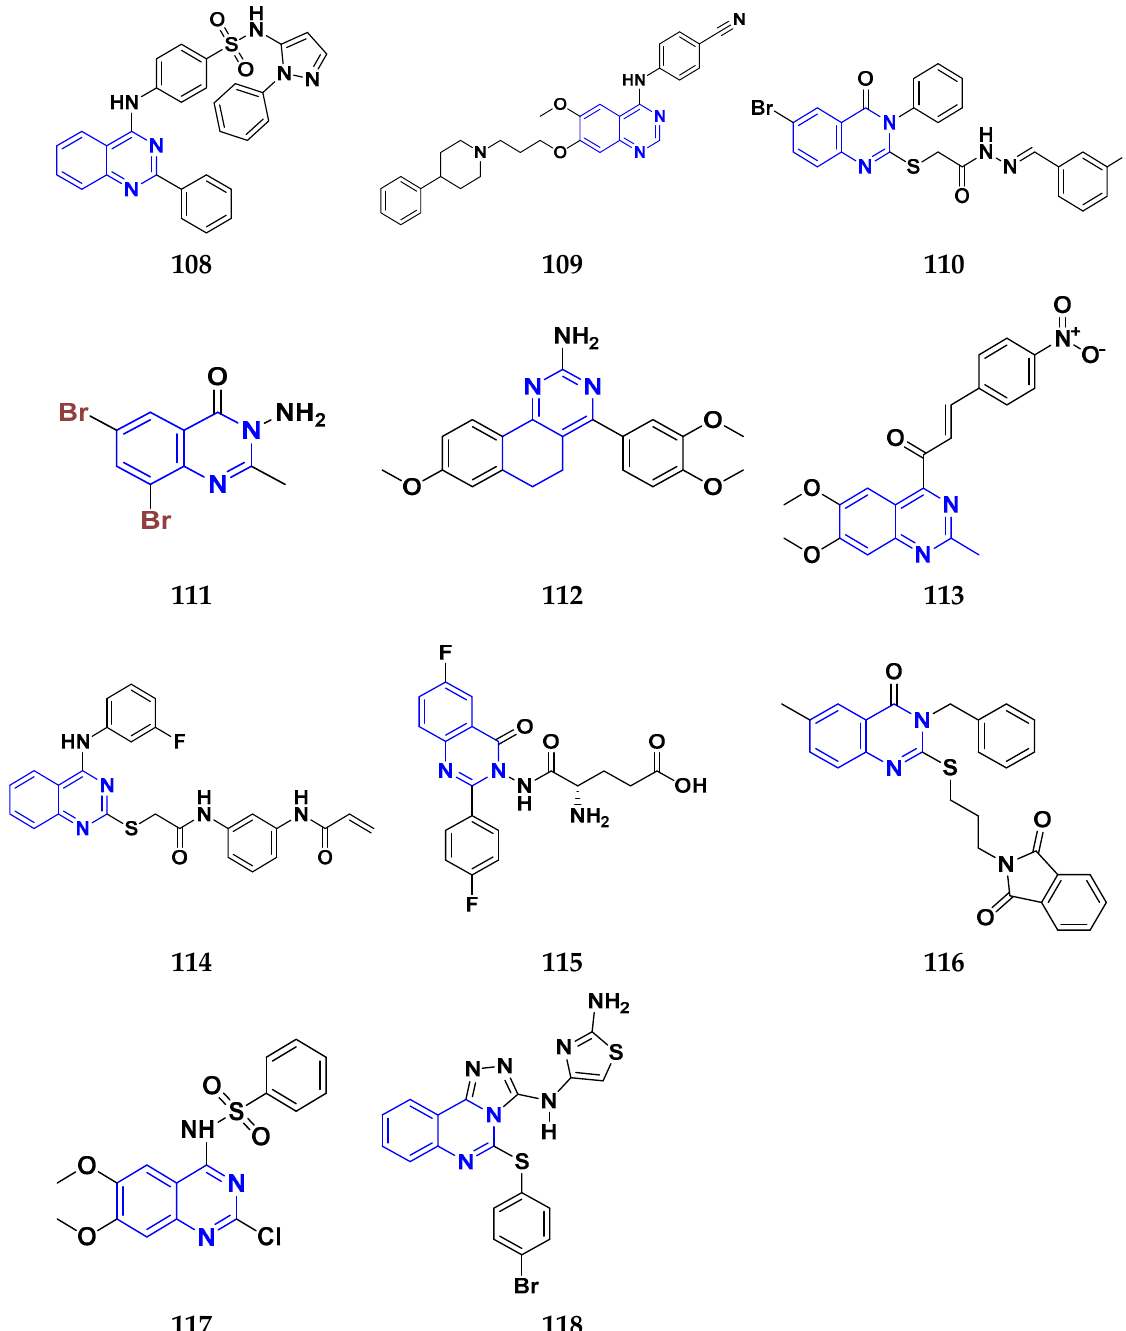
Figure 13. Quinazoline derivatives ( 108 – 118 ) as anticancer agents.